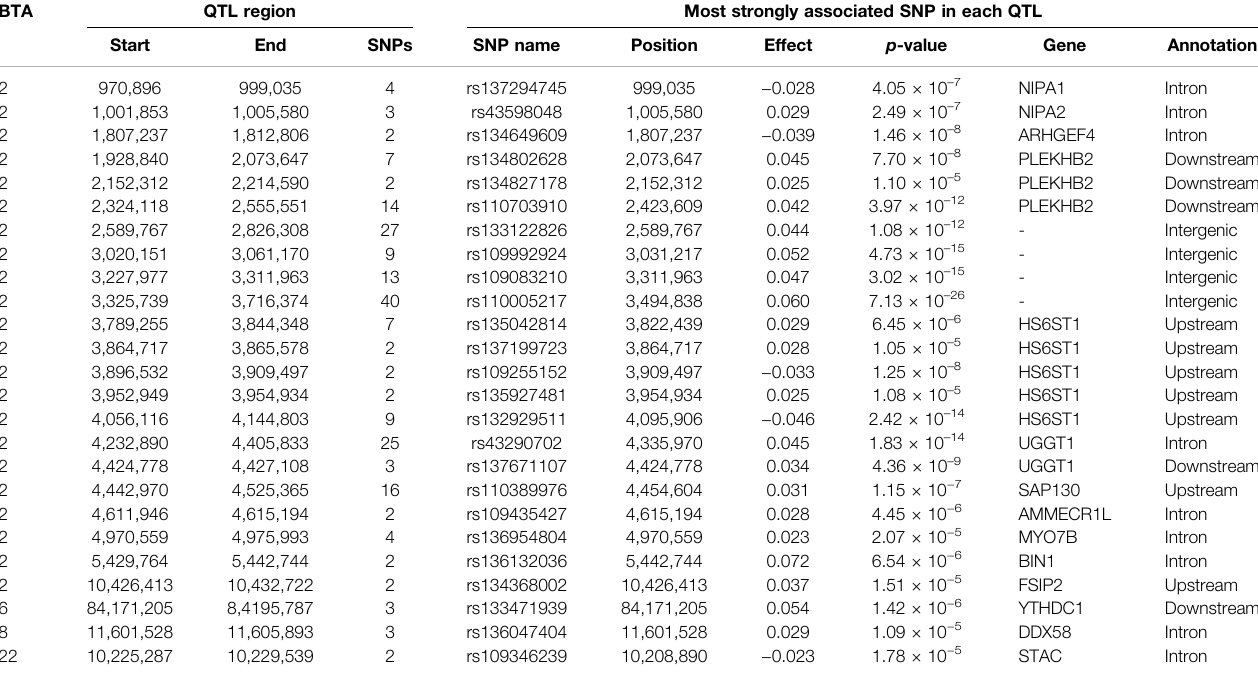
TABLE 3 | Chromosome (BTA), start and end position (bp), and number of signi fi cant and suggestive single nucleotide polymorphisms (SNPs) within the imprinted QTLs associated with carcass conformation, as well as SNP name, position, imprinting effect, p -value, nearest gene within 0.5 Mb and annotation of the lead